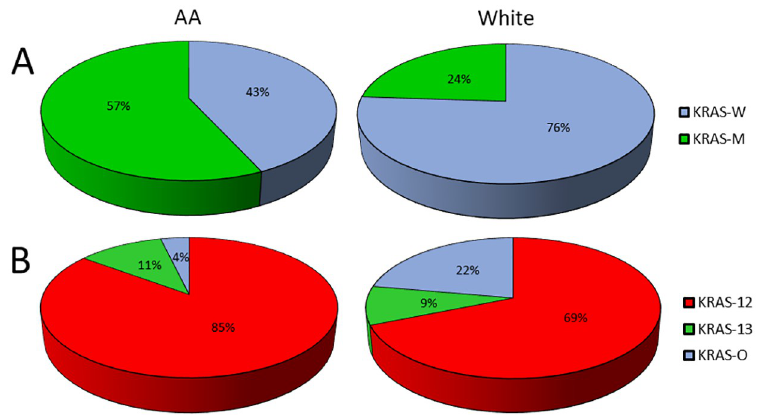
Fig 1. (A) Frequency of KRAS mutation is higher in AA compared with white patients. (B). Among all mutation tested, codon 12 mutation (KRAS-12) represents most common subtype for both AA and white patients, and has higher frequency in AA than white